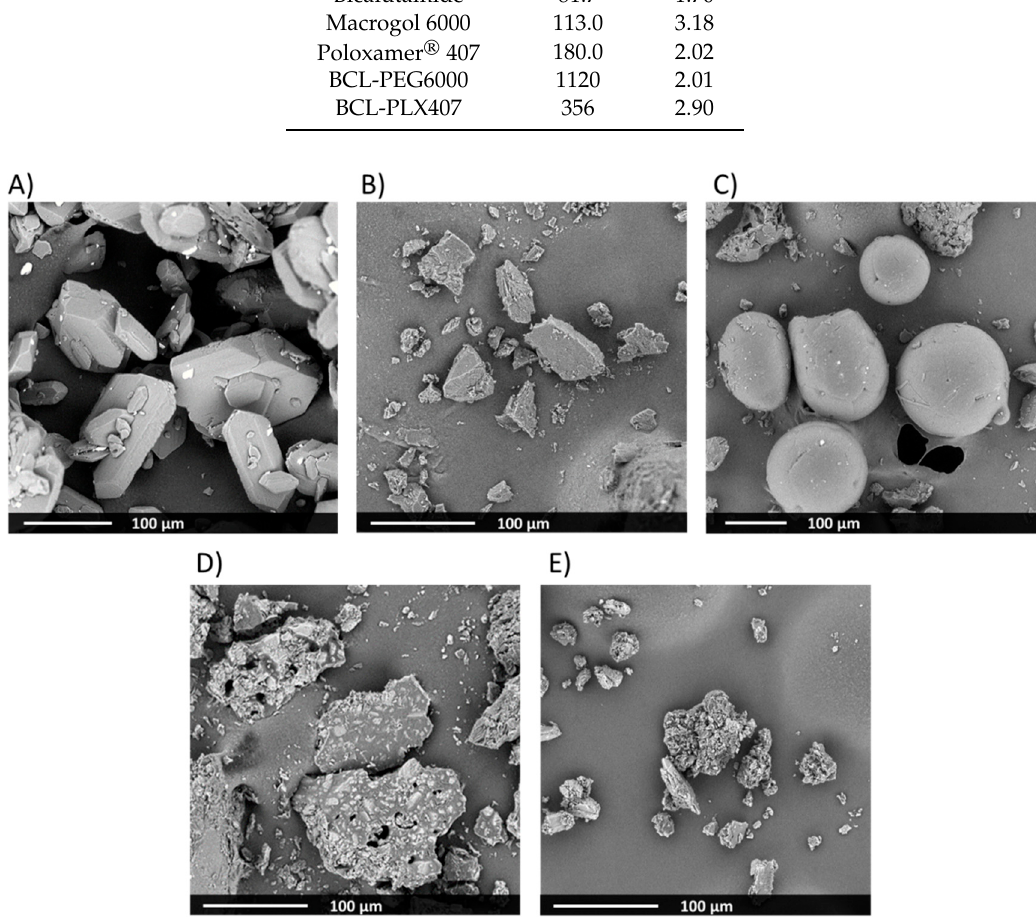
Table 1. Particles size distribution of raw bicalutamide and carriers, results obtained by the laser diffraction method.